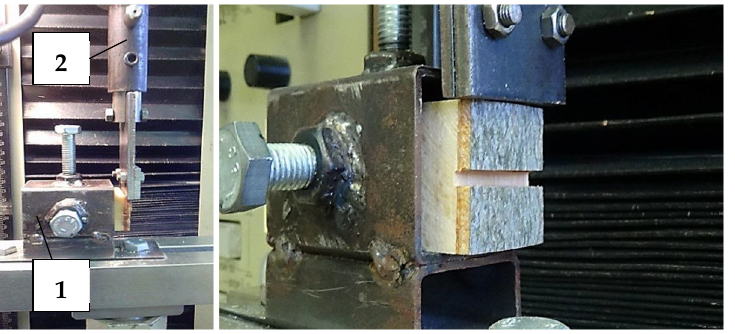
Figure 3. Depiction of the samples anchored by screws (1) and the jaw edges on the different wood/bark interfaces (2).